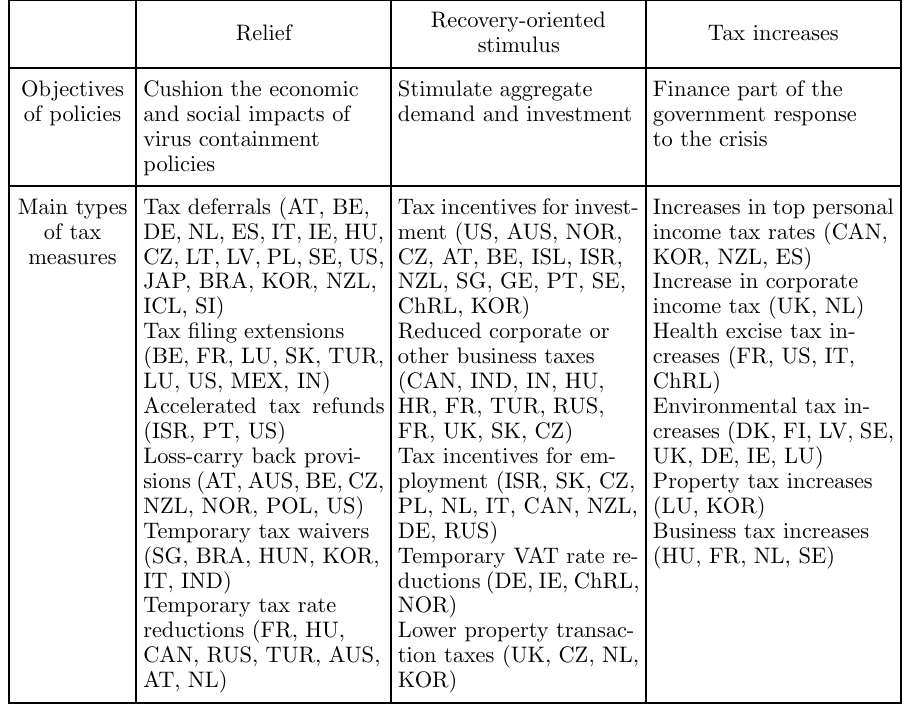
Typology of tax measures introduced in response to the COVID-19 crisis Recovery-oriented Relief Tax increases stimulus Objectives Cushion the economic of policies and social impacts